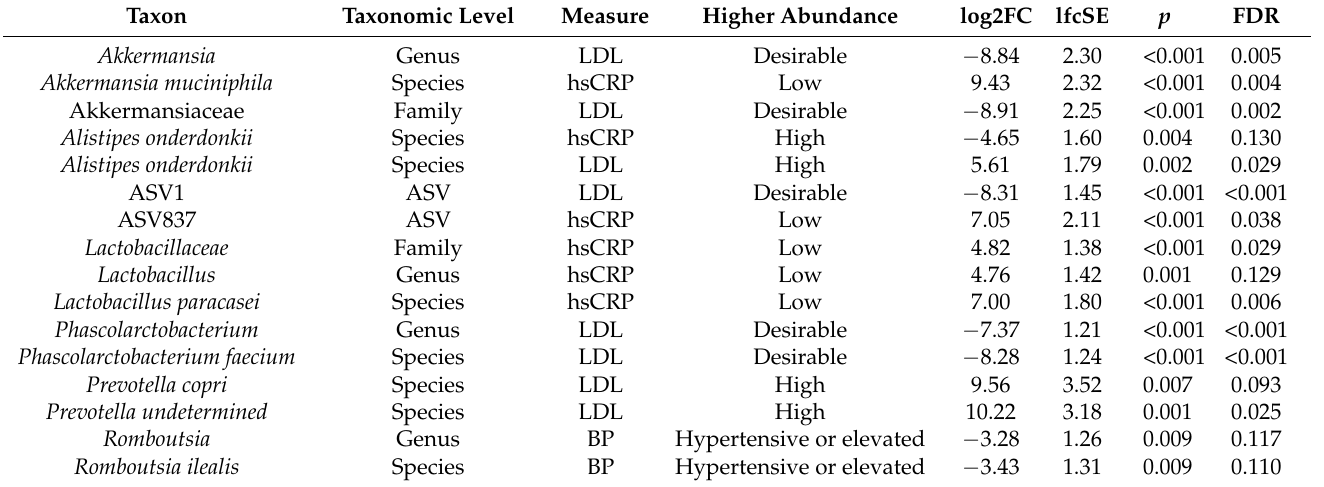
Table 4. Differentially abundant genera across clinical subgroups at T2. Taxa with differential abundance across hypertension, LDL, or hsCRP subgroups at T2, based on DESeq2 analysis. The subgroup with higher relative abundance is indicated for each clinical comparison, with log2fold change (log2FC), log fold change standard error (lfcSE), p value, and p value after false discovery rate correction (FDR). ASV1 is mapped to Firmicutes | Negativicutes|Acidaminococcales | Acidaminococcaceae | Phascolarctobacterium